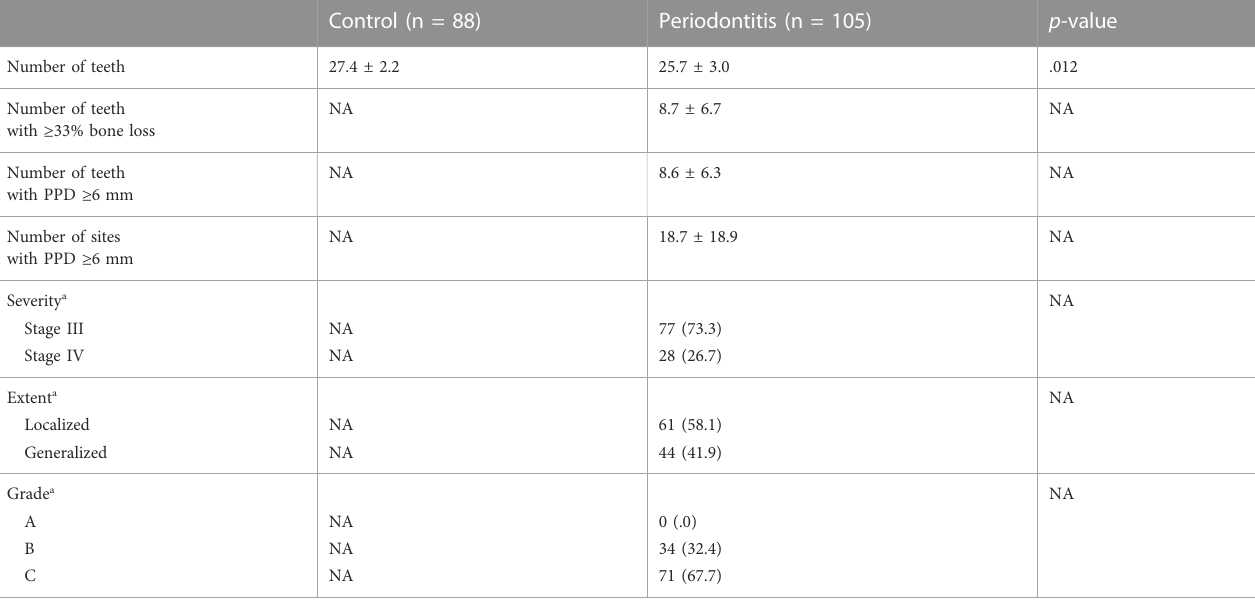
TABLE 2 Dental and periodontal parameters.